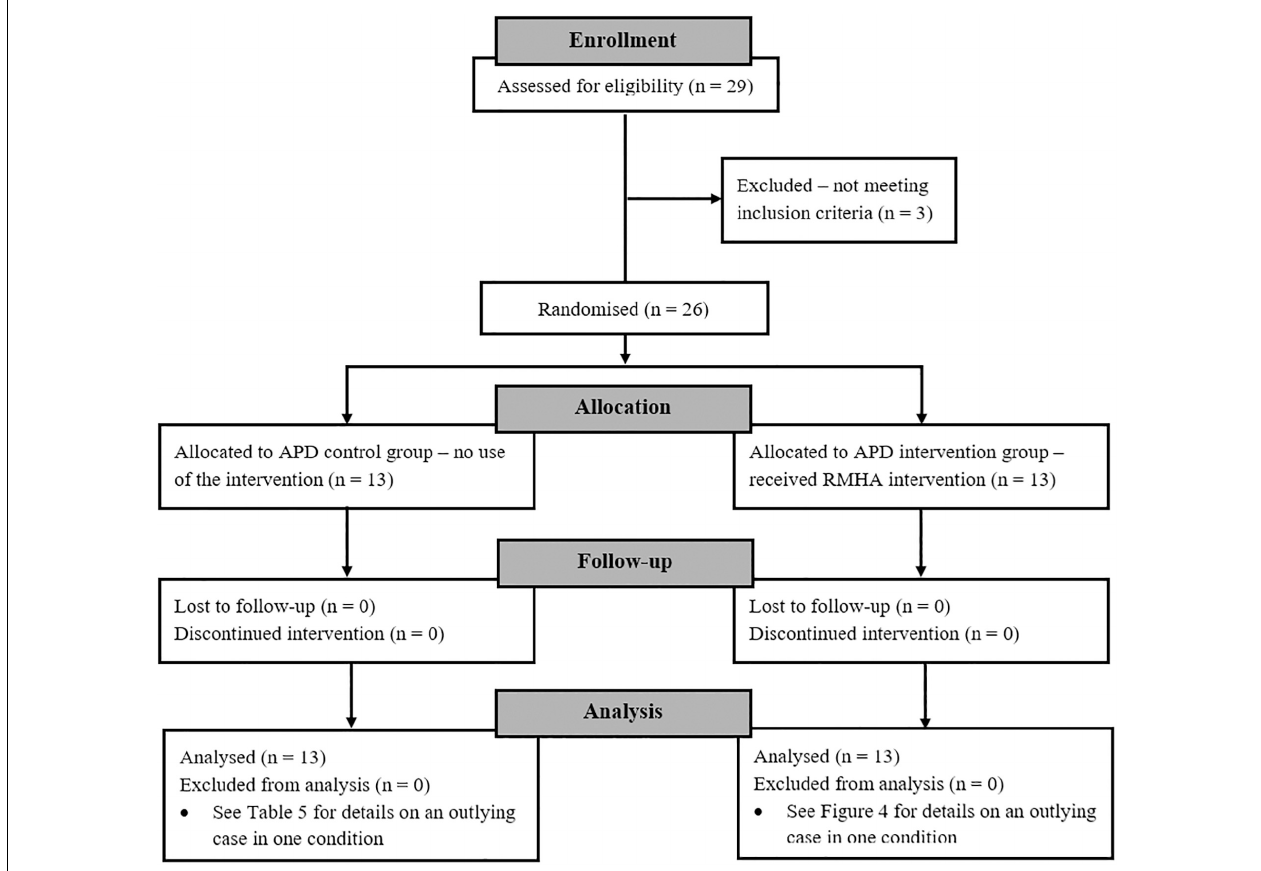
FIGURE 1 | Flow diagram showing the attrition through the different stages of the clinical trial. Three children were excluded after enrolment as they did not meet the inclusion criteria (see relevant section), while there was no loss of participants due to follow-up. APD, Auditory Processing Disorder; RMHA, Remote Microphone Hearing